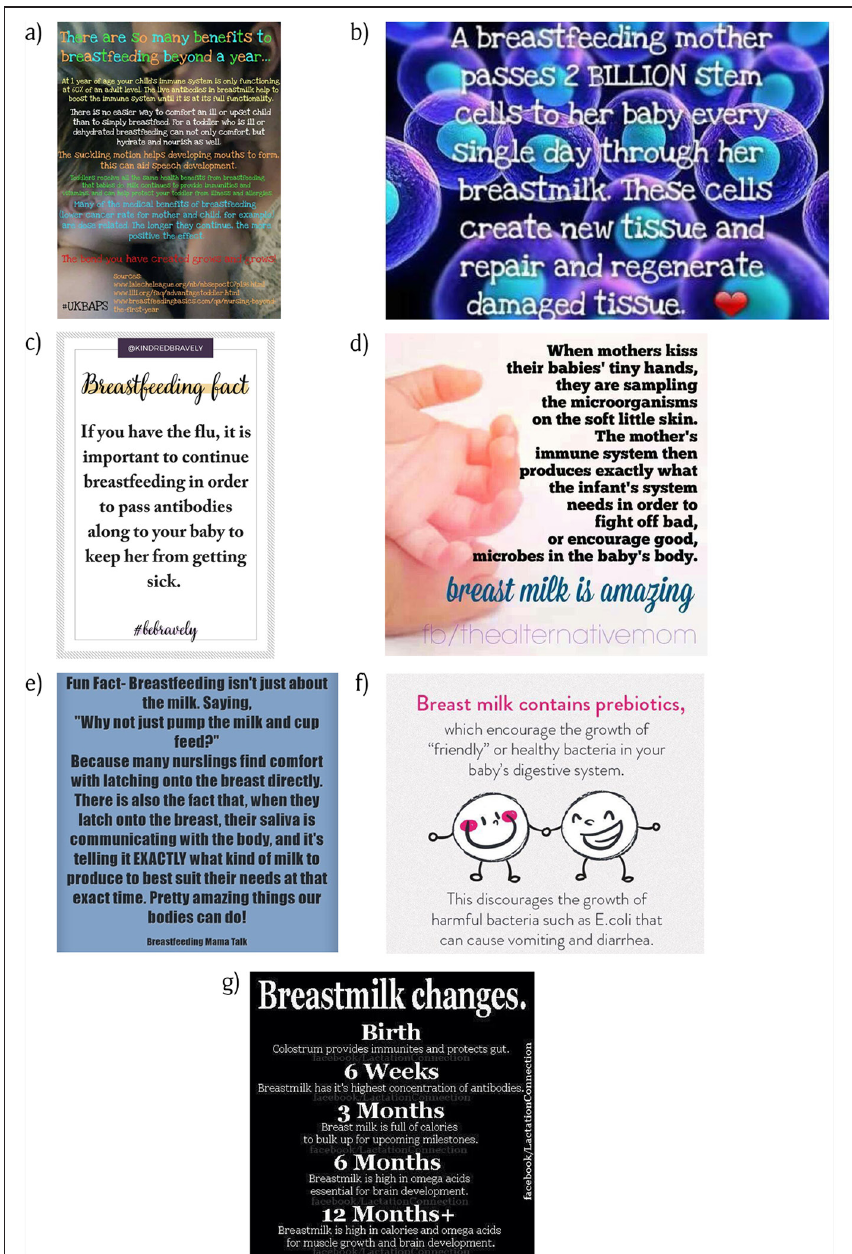
Figure 2: ‘Biomedical’ memes. (Source: A: UKBAPS/LJWhite; B: author unknown; C: bravely; D: the alternative mom (fb); E: BFMT; F: unknown; G: Lactation